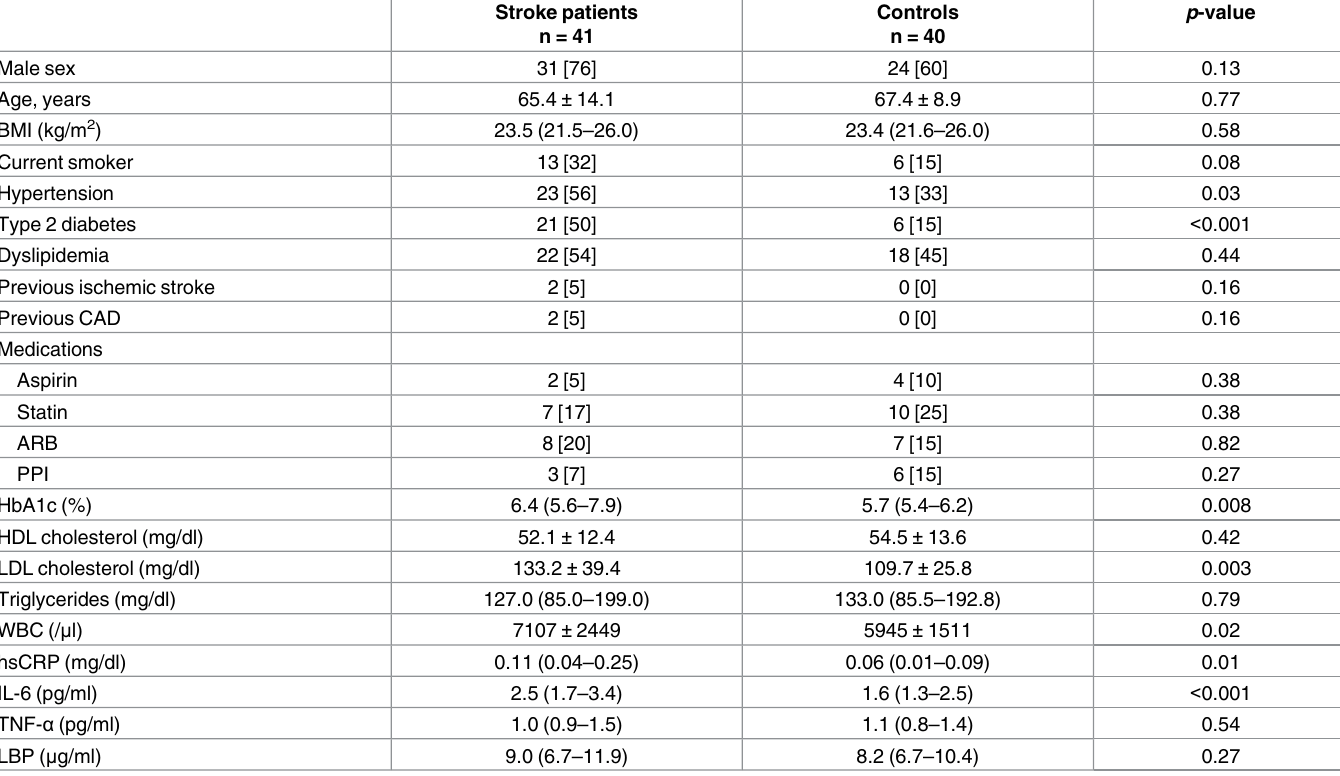
Table 1. Characteristics of the study